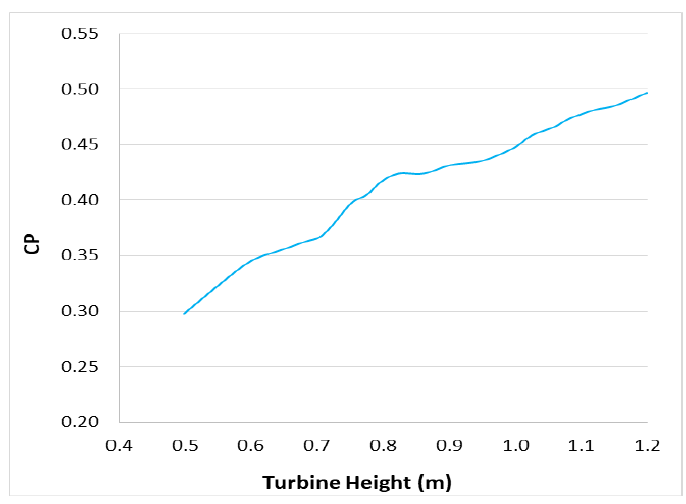
Figure 10. Coefficient of power vs. turbine height.